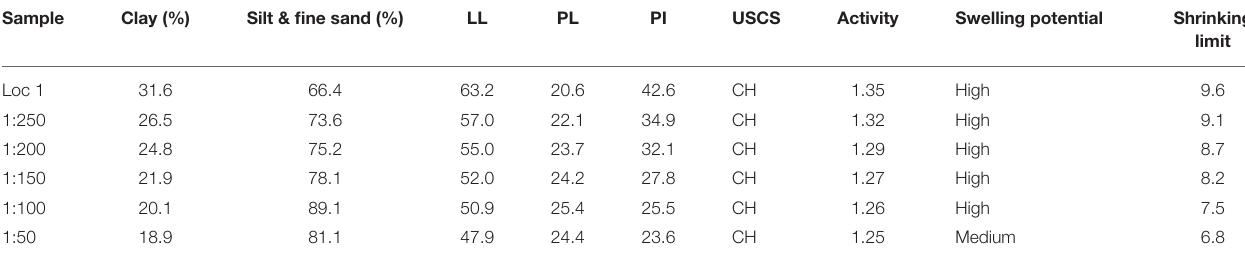
TABLE 9A | Properties of samples from various locations (source: analysis of laboratory results). Sample